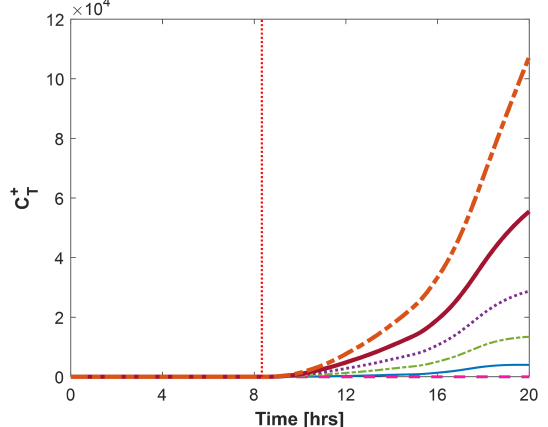
Figure 6. Variation in temperature anomaly score with anomaly magnitude for air–flow anomaly with anomaly initiation (dotted) at 8.33 h: Threshold (dashed), ϑ = 0.2 (solid), ϑ = 0.4 (dash-dotted), ϑ = 0.6 (dotted), ϑ = 0.8 thick (solid), ϑ = 1 (thick